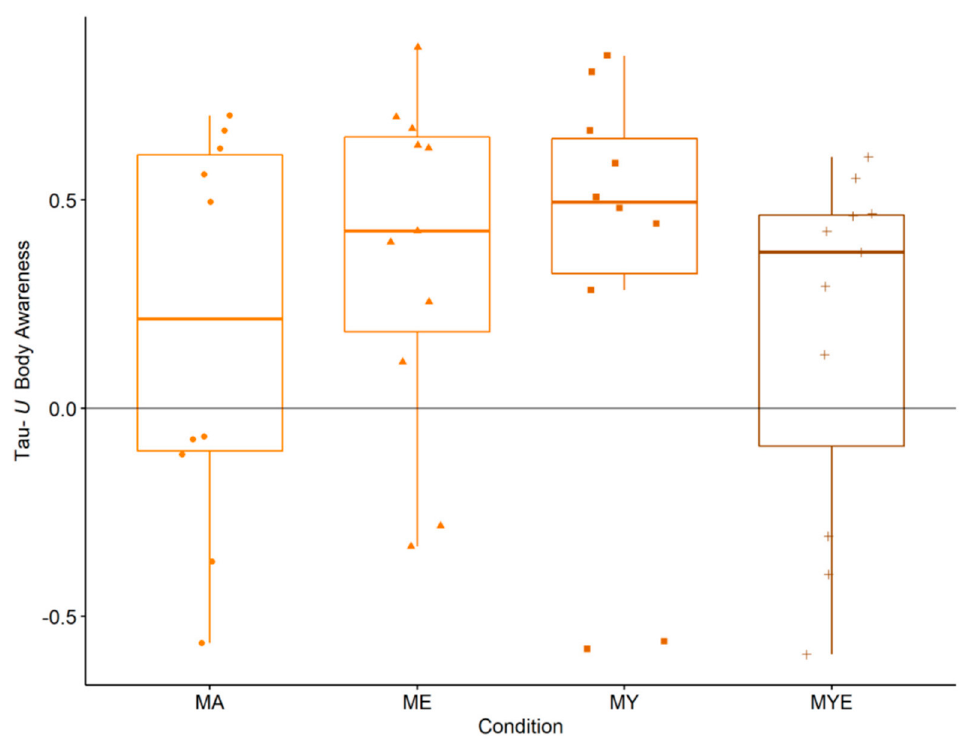
Figure 2. Box plots for averaged Tau- U body awareness effect size estimates in each condition. Individual estimates are scattered across the box plots. Note. MA = Mantra meditation only (dots); ME = meditation and ethical education (triangles); MY = meditation and physical yoga (squares); MYE = meditation, physical yoga, and ethical education (pluses). Whiskers represent the largest and lowest values within a distance of 1.5 times the interquartile range.